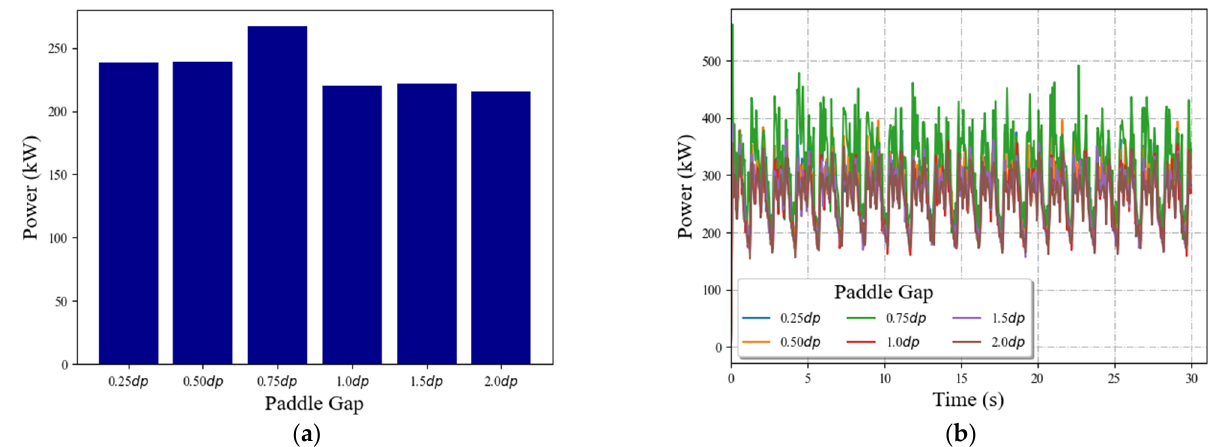
Figure 23. Power consumption of the mixer with various paddle gaps: ( a ) mean power consumption and ( b ) transient power consumption.